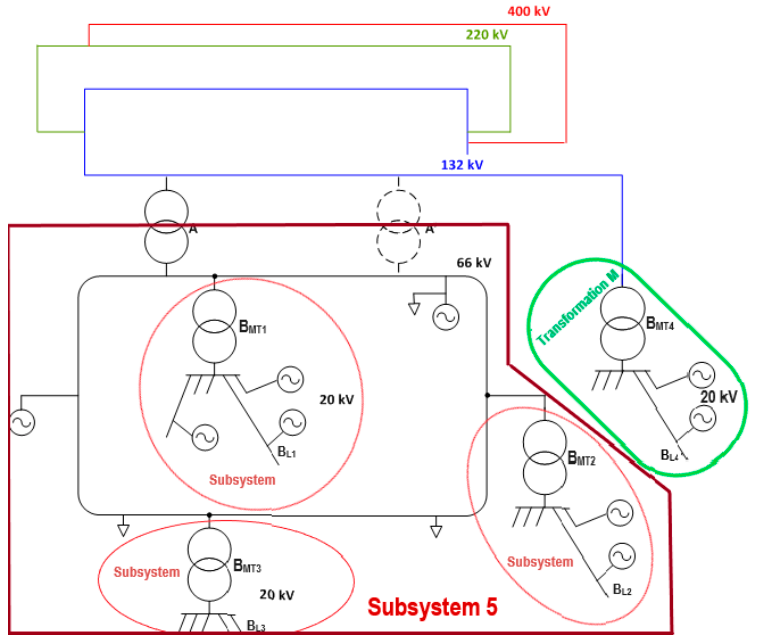
Figure 5. Subsystems identification with simple or multiple connection points with the higher voltage level.